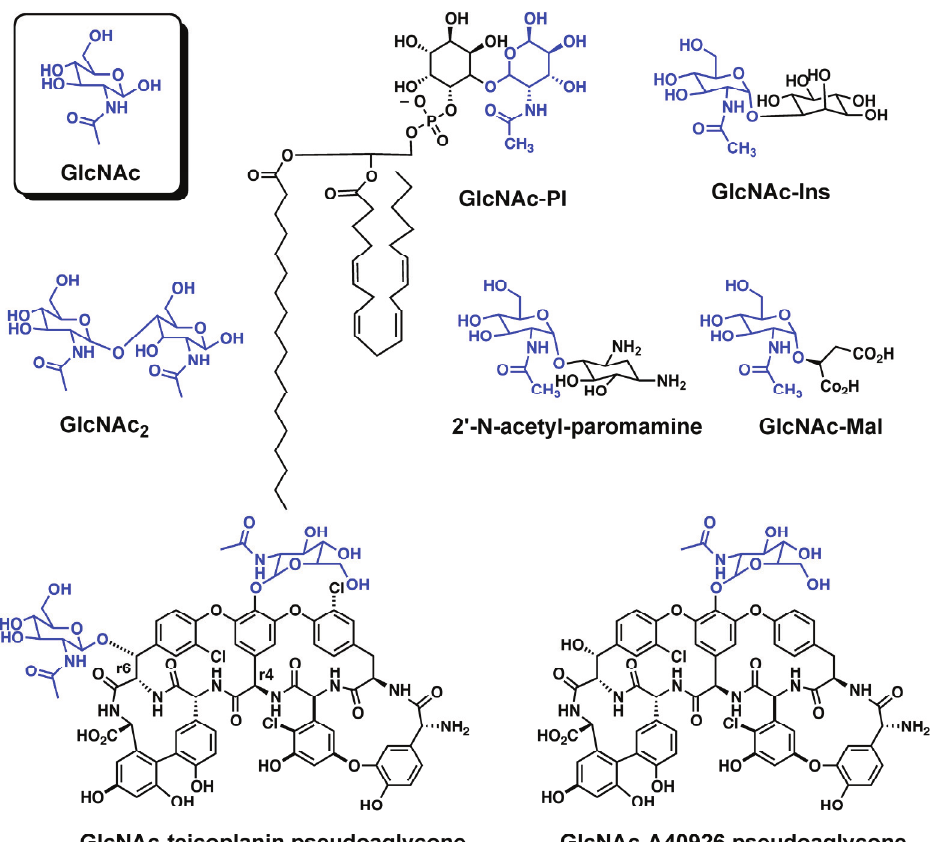
Figure 2. Substrates for LmbE-like enzymes that catalyze deacetylation reactions. The GlcNAc moieties are shown in blue. For molecules that contain more than one GlcNAc moiety, please refer to the text for clarification on the GlcNAc moiety that is